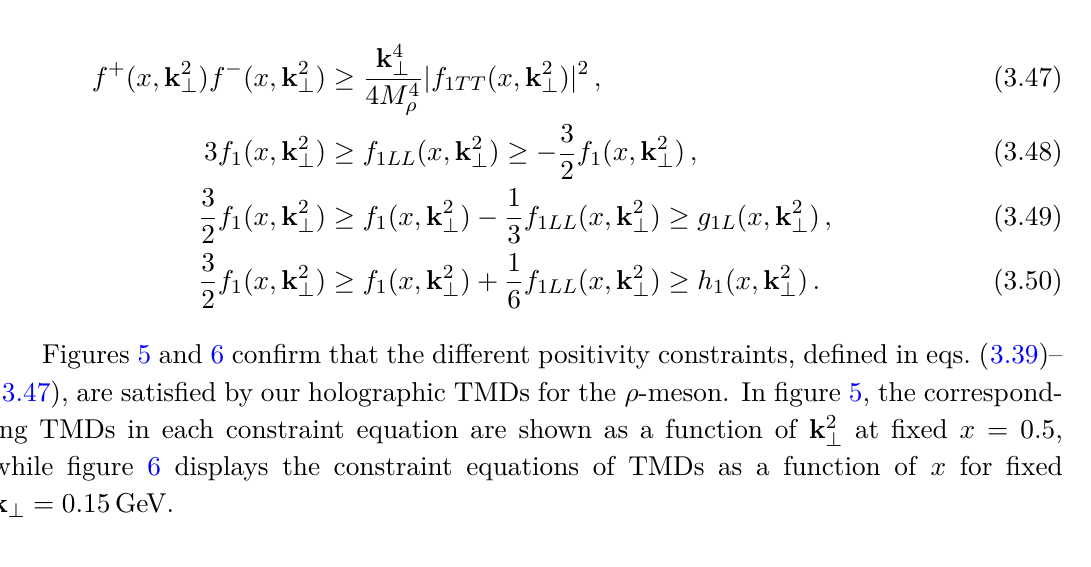
Figure 5 . The positivity constraints on the holographic TMDs, plotted with respect to k 2 x = 0 . 5